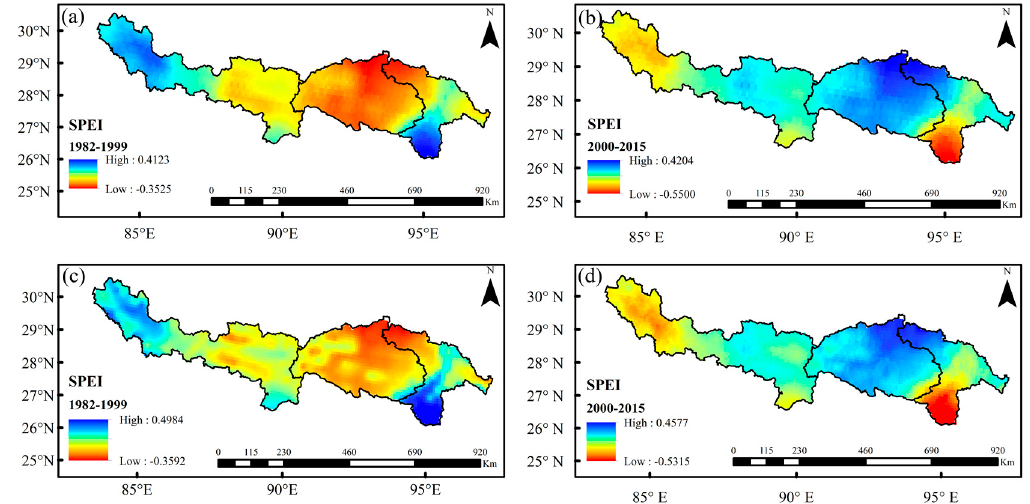
Figure 7. Annual ( a, b ) and growing season ( c, d ) spatial distributions of SPEI.